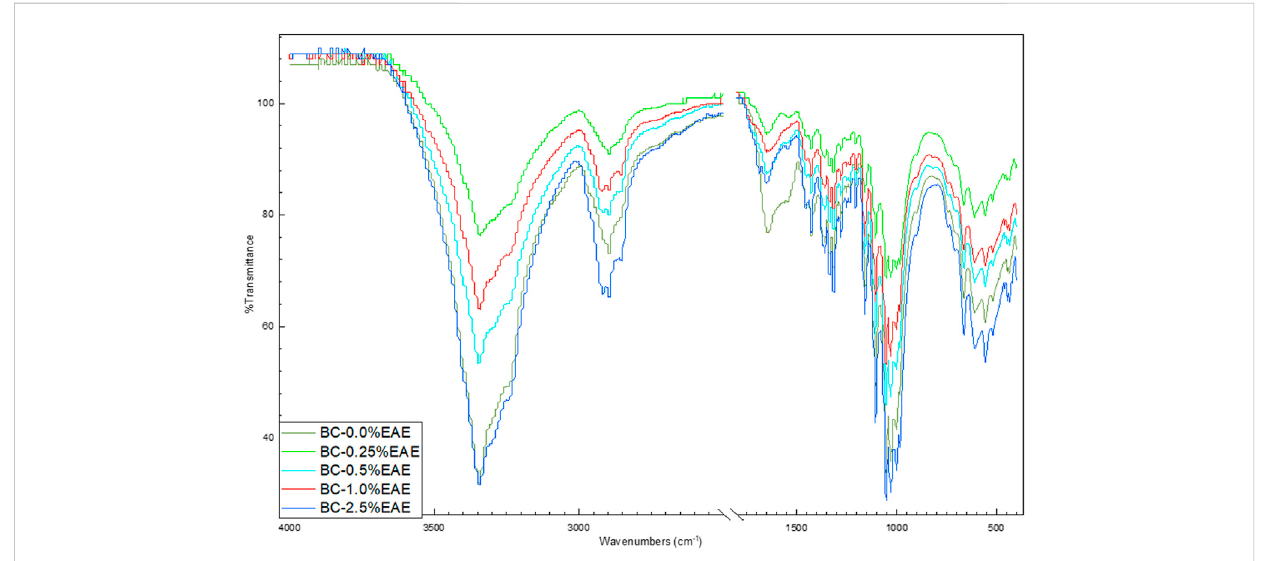
FIGURE 1 ATR-FTIR spectra of bacterial cellulose — BC (violet), BC-0.25%EAE (light blue), BC-0.5%EAE (green), BC-1%EAE (red), and BC-2.5%EAE (dark